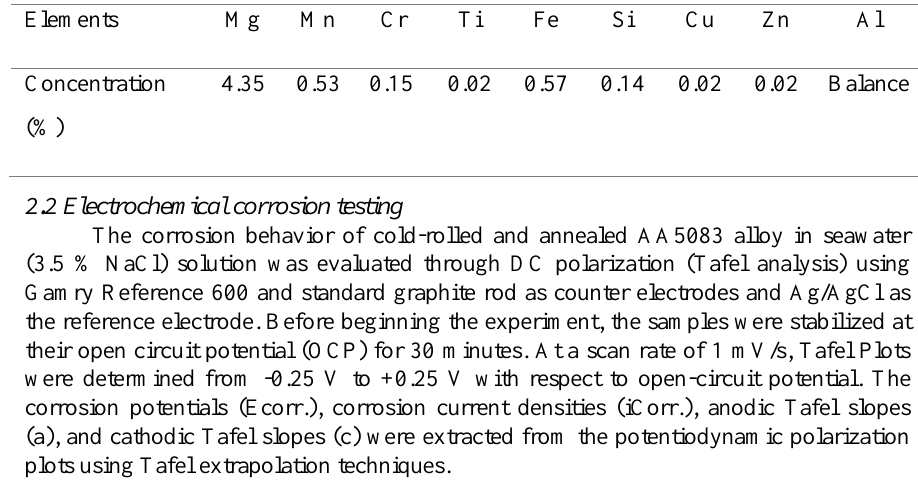
Table 1. Chemical Composition of AA5083